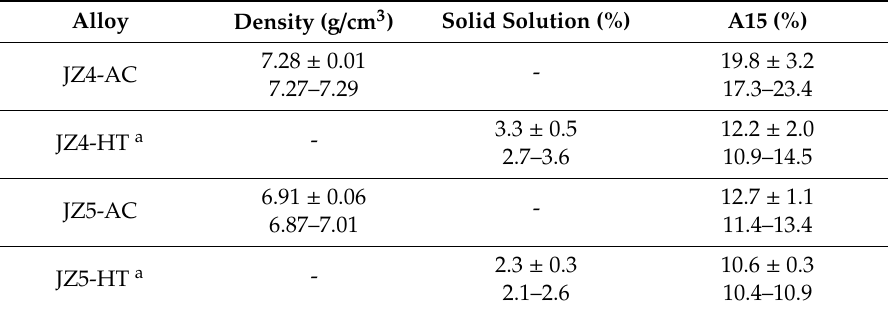
Table 1. Density of the as-cast (AC) alloys and area % of selected phases in the bulk of the as-cast and heat-treated (HT) alloys JZ4 and JZ5.